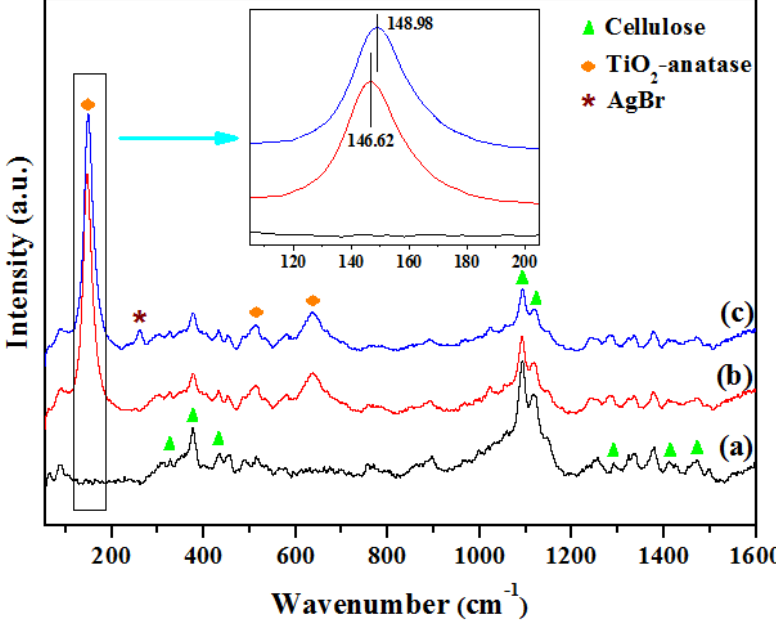
Figure 1. Raman spectra of neat paper ( a ), paper–TiO 2 ( b ) and paper–TiO 2 –AgBr ( c ).